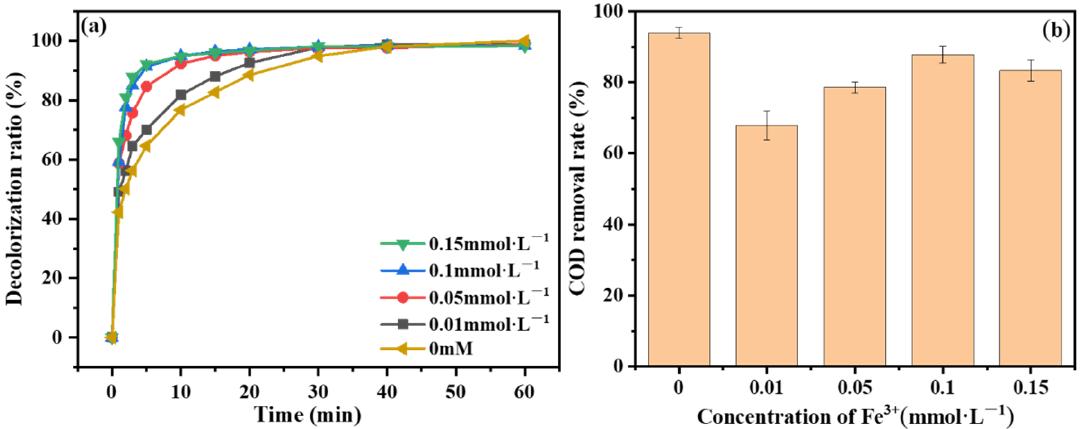
Figure 6. Effect of different Fe 3+ concentrations on the ( a ) decolorization rate of ARG and ( b ) COD removal rate in the Fe 3+ /H 2 O 2 /CSPAC system (0–0.15 mmol/L FeCl 3 , 0.4 mmol/L H 2 O 2 , 100 mg/L ARG, 0.6 g/L CSPAC (75 μ m particle size), pH = 3).